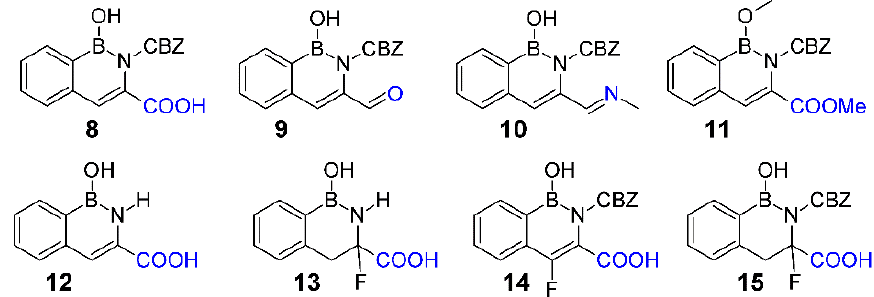
Figure 2. Structures of the computationally optimized azaborine-3-carboxylates. The stability of the models was estimated by calculating the HOMO-LUMO gaps of all compounds. Figure 3 shows the FMO energy diagrams and the corresponding energy gaps (eV) for compounds 1 – 15 .